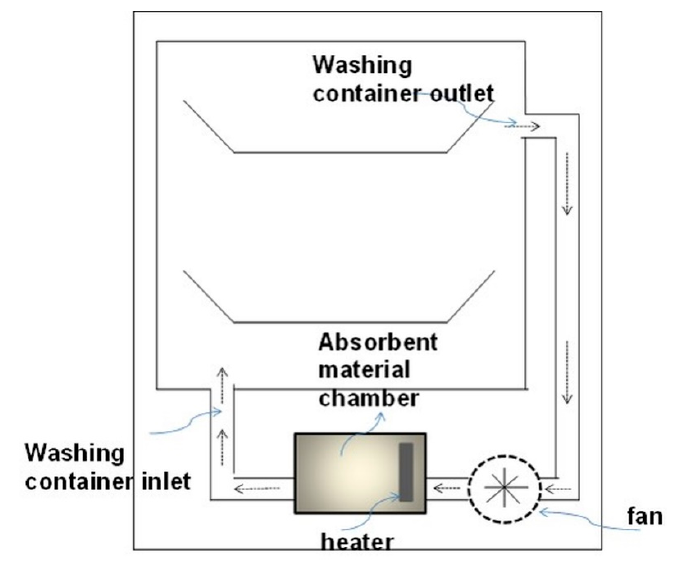
Figure 8. Schematic of a designed dishwasher for the prototype testing of aerogel particles.